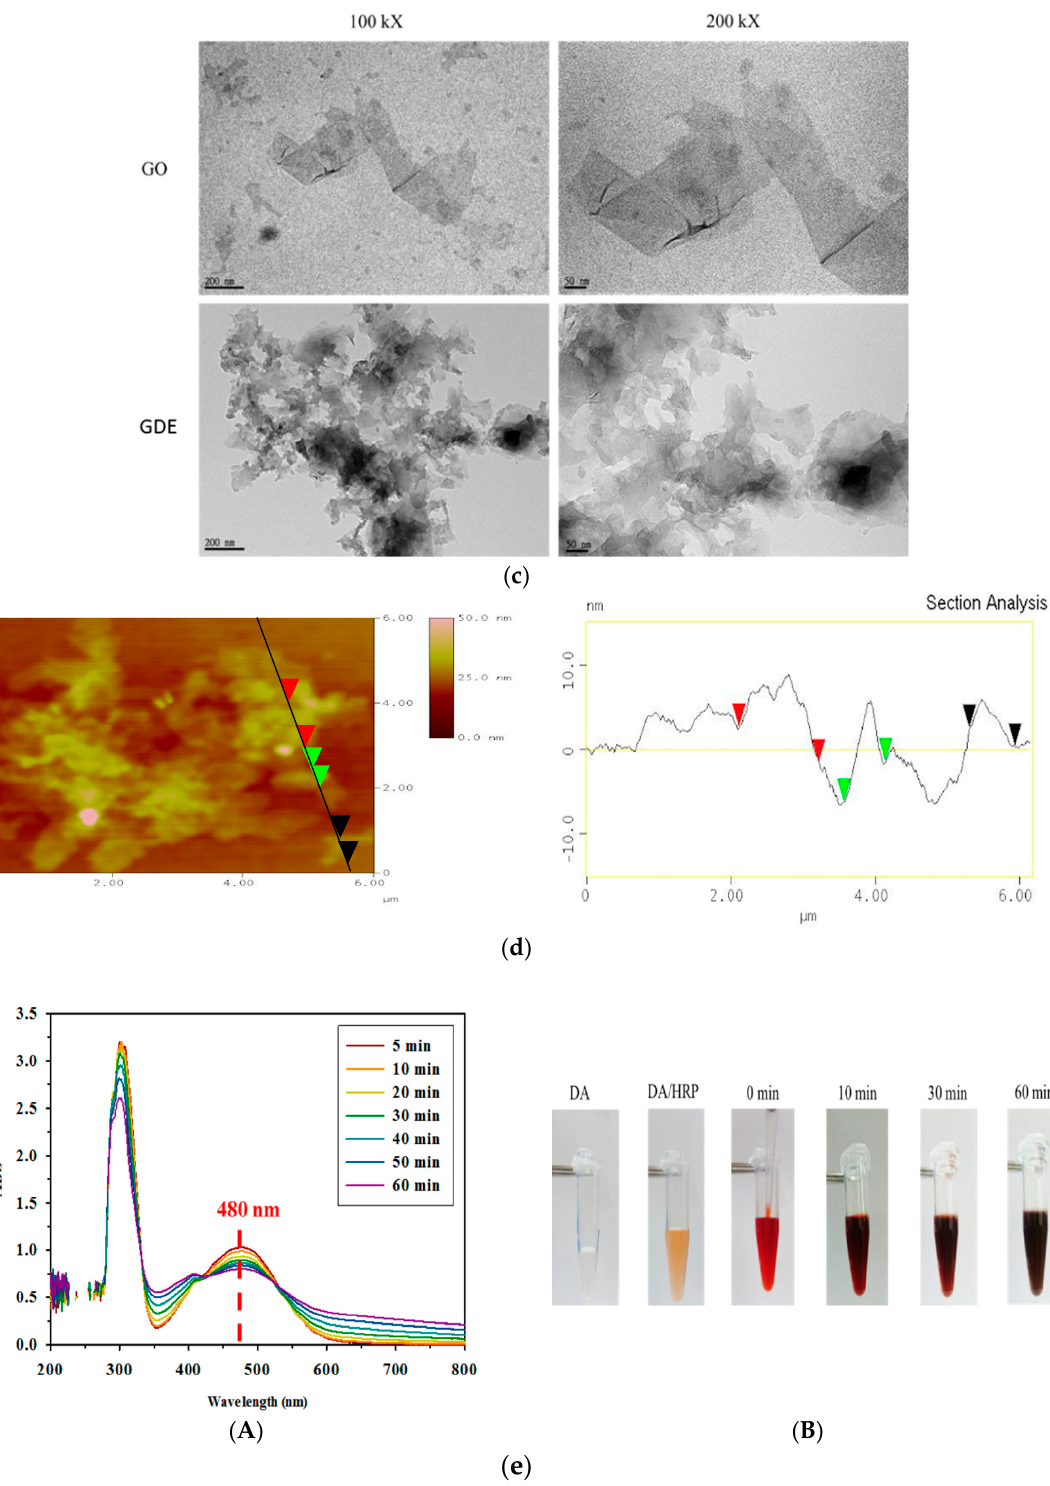
Figure 1. ( a ) Schematic figure for fabricating GDES films, ( b ) Schematic figure for the principle of scavenging / probing H 2 O 2 by GDES films. ( c ) TEM micrographs for GO and GDE microaggregates were shown. ( d ) The AFM image for GDE microaggregates was shown. ( e ) polymerization of dopamine to PDA catalyzed by HRP. ( A ) UV-Vis absorbance kinetics; ( B ) color changes during PDA formation. Absorbance at 480 nm, which correlates to the red intermediate during polymerization decrease over time.